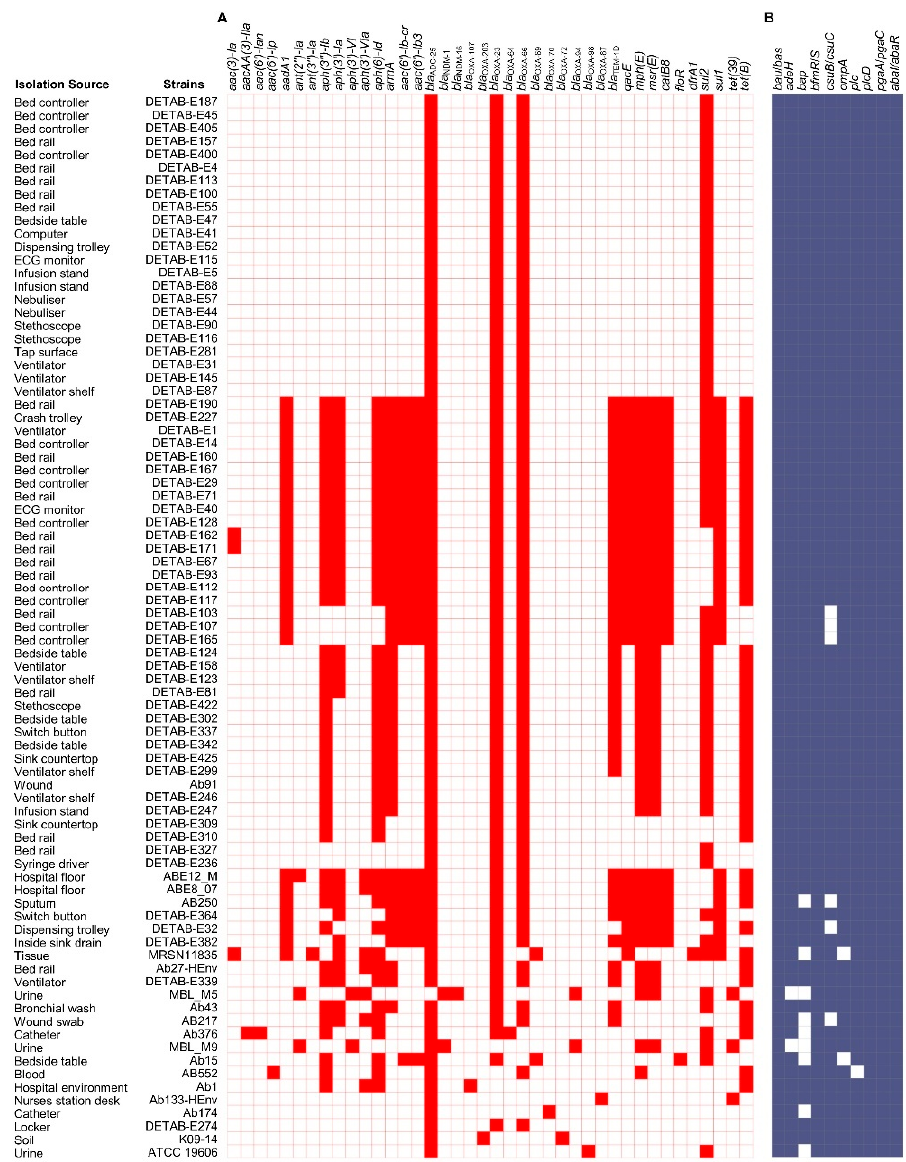
Figure 4. Genomic analysis of antimicrobial resistance genes (ARGs) and virulence factors. ( A ) The pattern of acquired resistance genes and ( B ) virulence factors associated genes in the A. baumannii genomes. The white box indicates the respective gene was not detected.